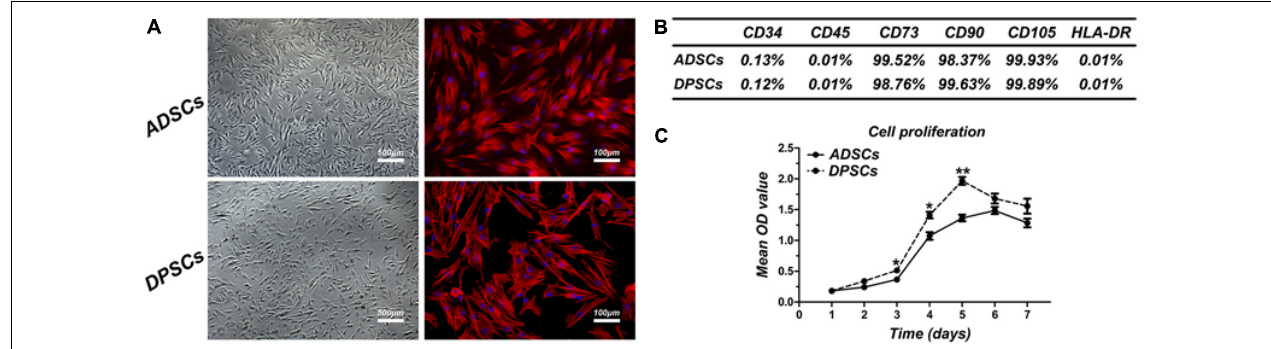
FIGURE 1 | Comparison of cell characteristics of adipose-derived stem cells (ADSCs) and dental pulp stem cells (DPSCs). (A) Cell morphology of post-thawed ADSCs and DPSCs. (B) The results of flow cytometric analysis of cryopreserved ADSCs and DPSCs. (C) Proliferation curves of cryopreserved ADSCs and DPSCs. Data are presented as the mean ± standard deviation, * P < 0.05, ** P < 0.01.